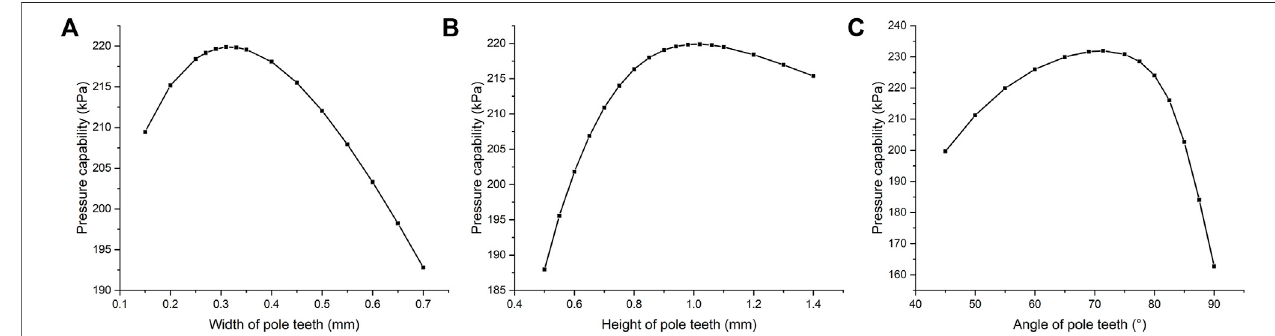
Frontiers in Materials |